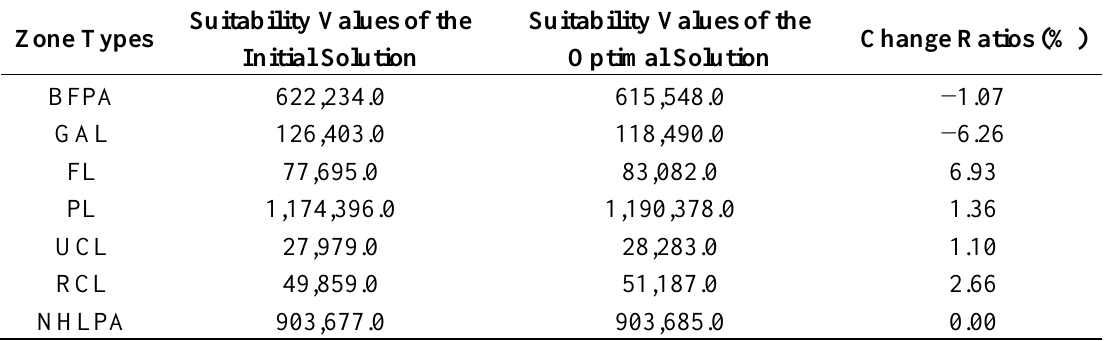
Table 9. Suitability values of the initial and optimal solutions for each type of